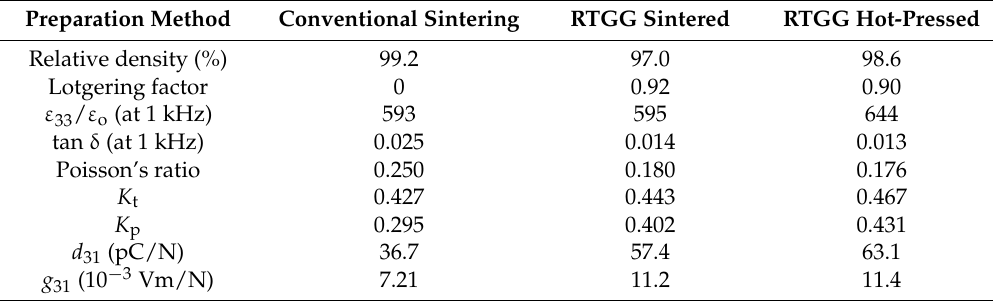
Table 1. Properties for BNT-BKT ceramics prepared by different methods.